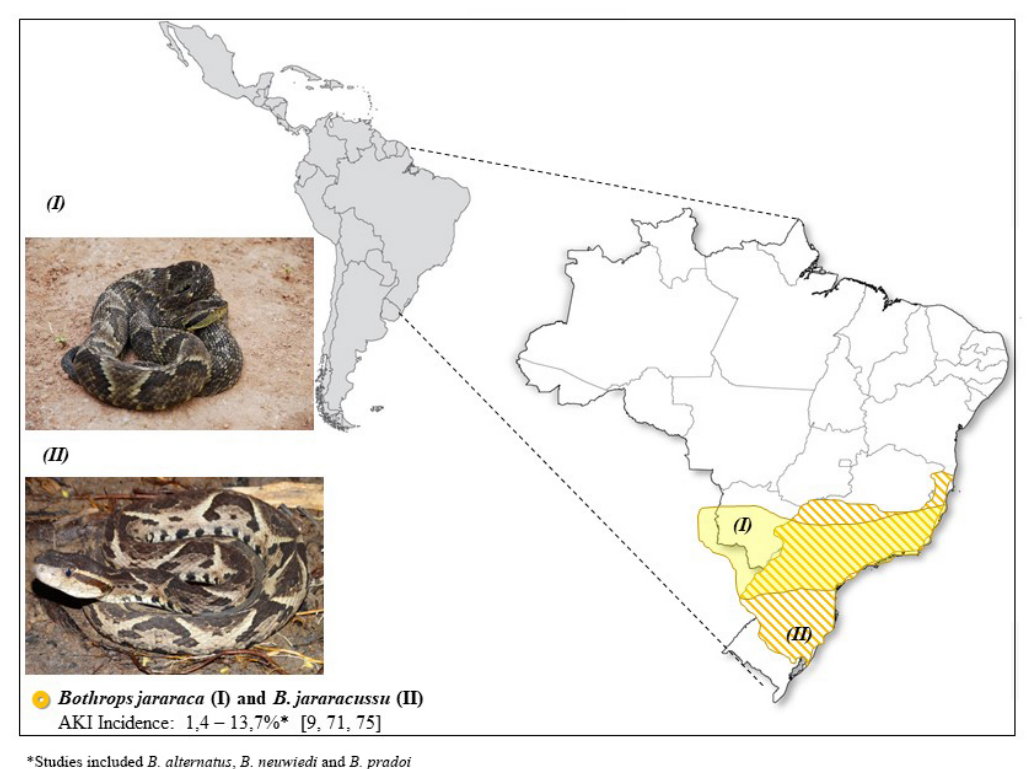
Figure 4. Geographical distribution of Bothrops jararaca (photo courtesy of Marcelo Duarte) and Bothrops jararacussu (photo courtesy of Paulo Bernarde, Federal University of Acre) and the incidence of AKI.